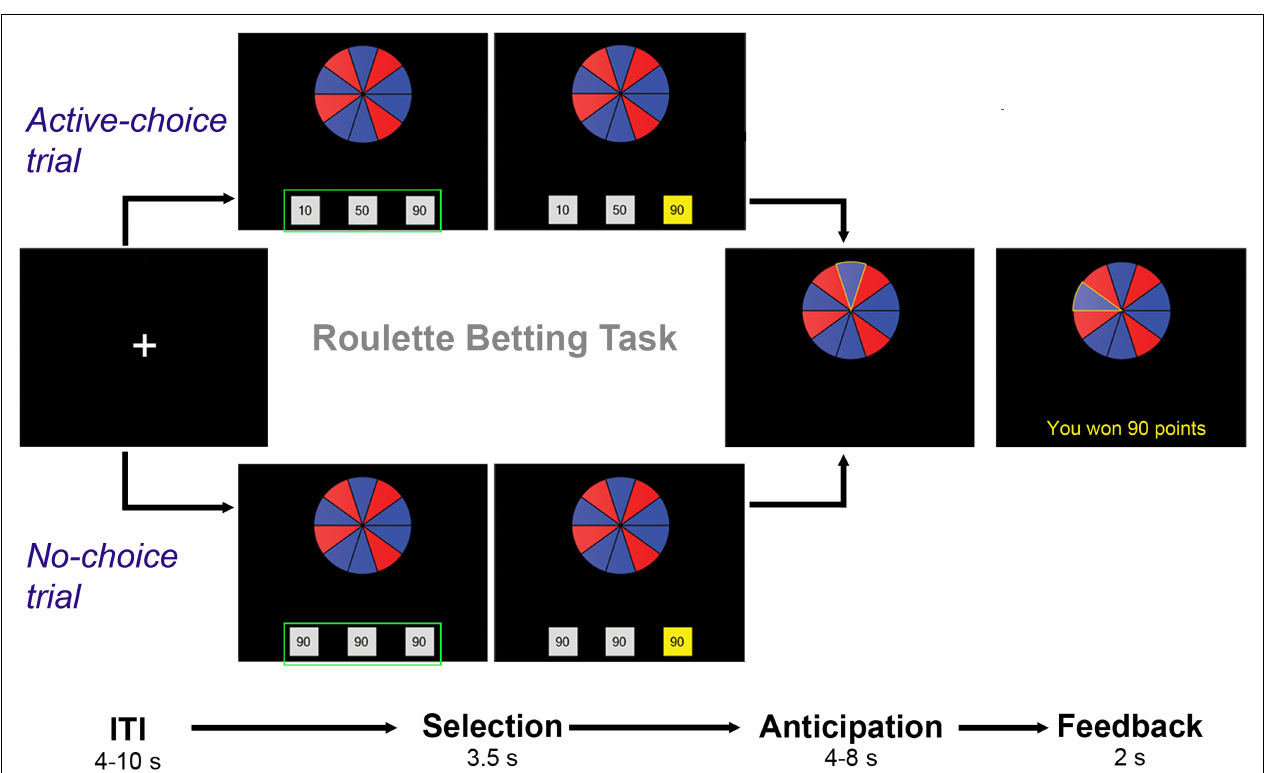
were identical, except that in active-choice trials participants were presented with three different bet options, while in no-choice trials all three bet boxes contained identical amounts.The green box was added to this graph for illustration purposes